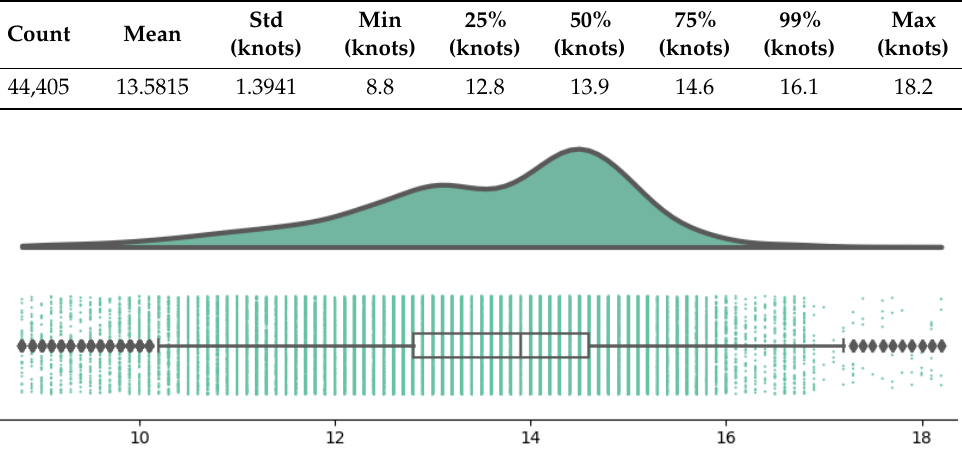
Figure 5. Histogram and boxplot of SOG data.